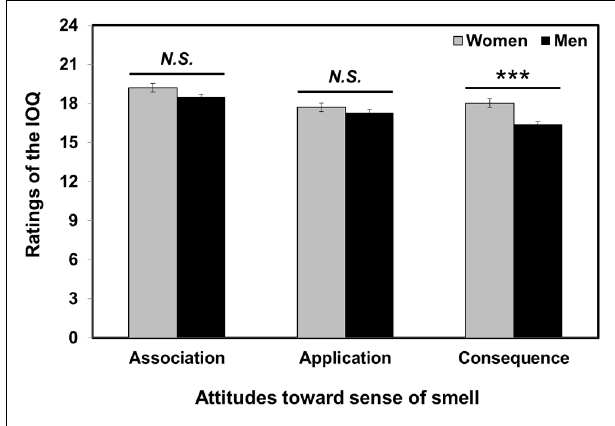
FIGURE 1 | Gender differences in the attitudes toward sense of smell. Mann–Whitney U -tests revealed that women participants rated consequence-subscale of the IOQ (Importance of Olfaction Questionnaire) significantly higher than men participants.The asterisks (***) indicate significance at P < 0.001. Error bars represent standard error of the